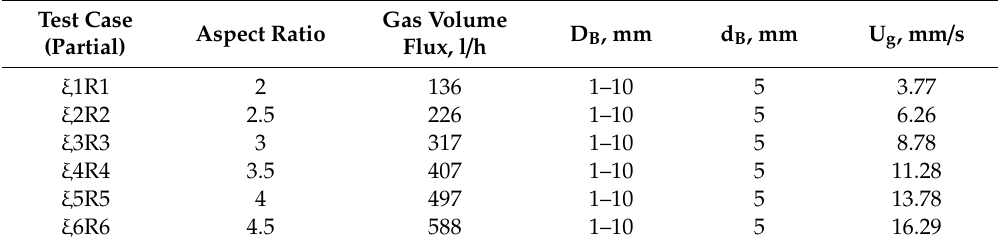
Table 4. Details of the partial working conditions adopted in the simulation